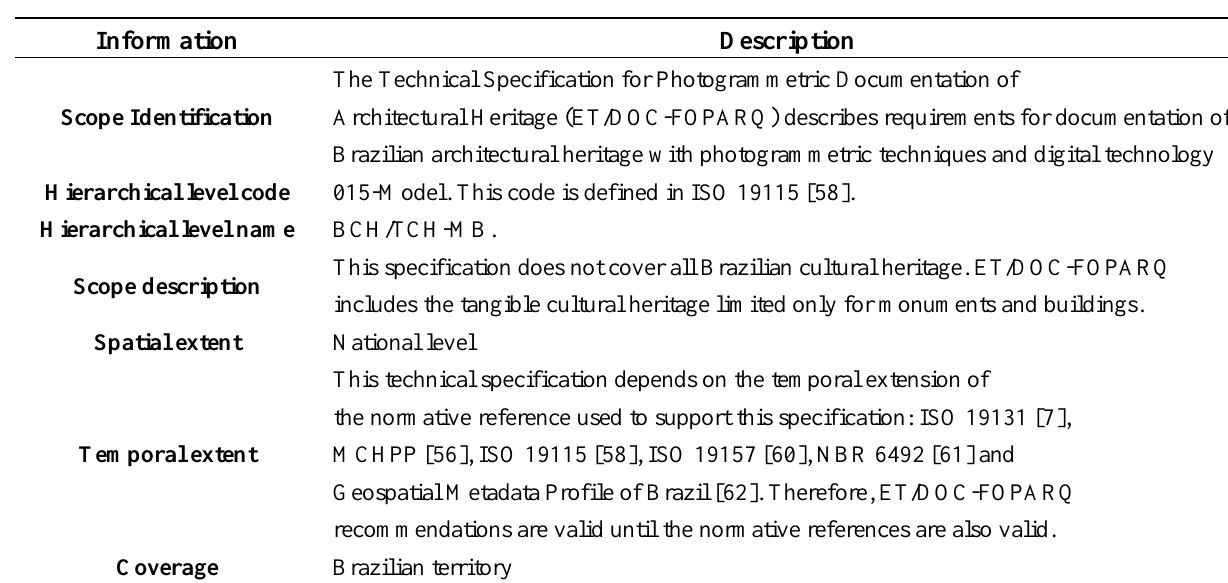
Table 3. Specification